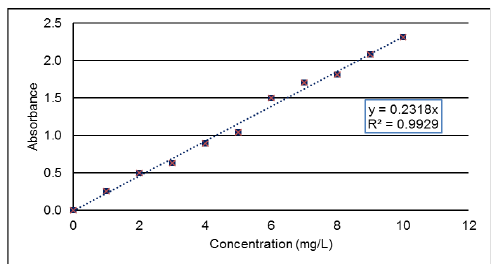
Fig. 4. A plot of absorbance as a function of the concentration of methylene blue